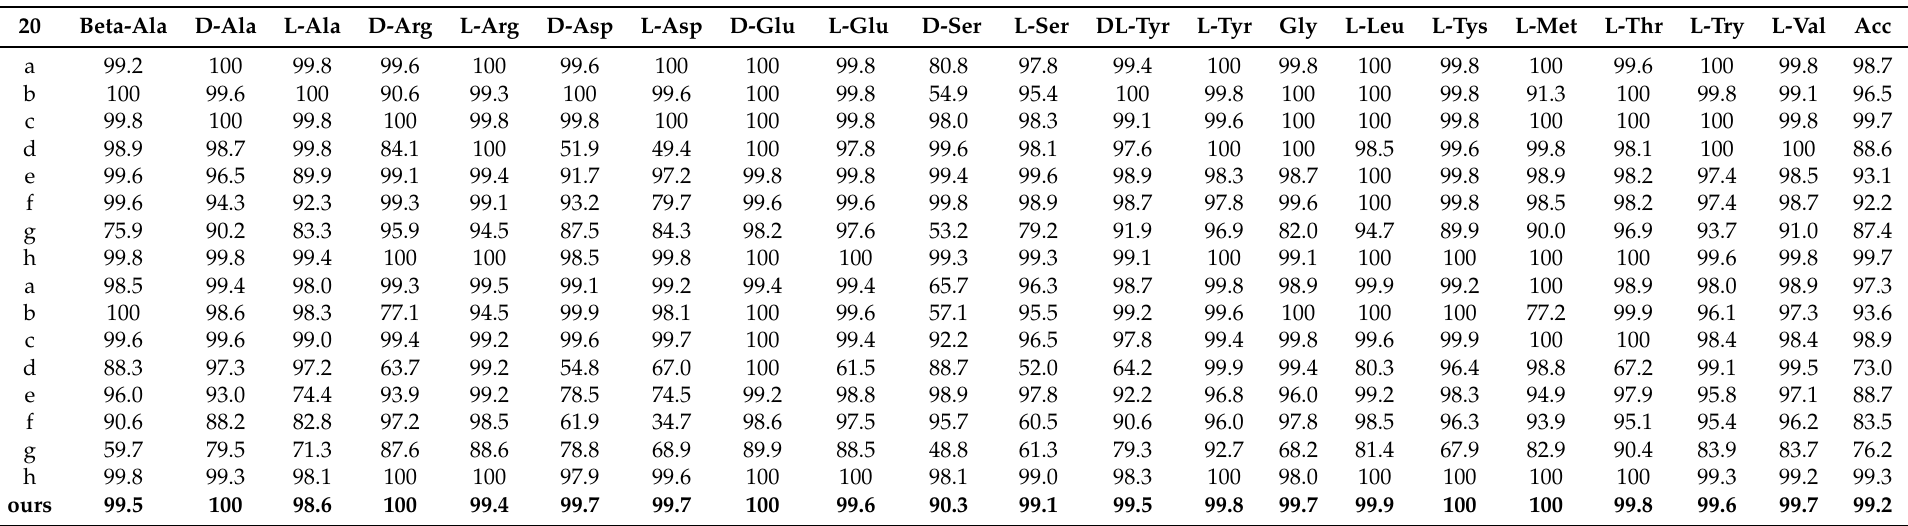
Table 2. The precision and accuracy of classification of 20 amino acids on Average20 and Average10 datasets. From a to h are: a. ECA network with absorption rate as input; b. ECA network with refractive index as input; c. plain CNN with hybrid spectrum as input; d. ECA-DDCNN [33] with hybrid spectrum as input; e. ECA-Resnet50 [24] with hybrid spectrum as input; f. ECA-Resnet101 [24] with hybrid spectrum as input; g. CNN-BiGRU referred from [23]; h. CNN referred from [22]. Ours denotes the ECA network with hybrid spectrum as input. The values in the table are